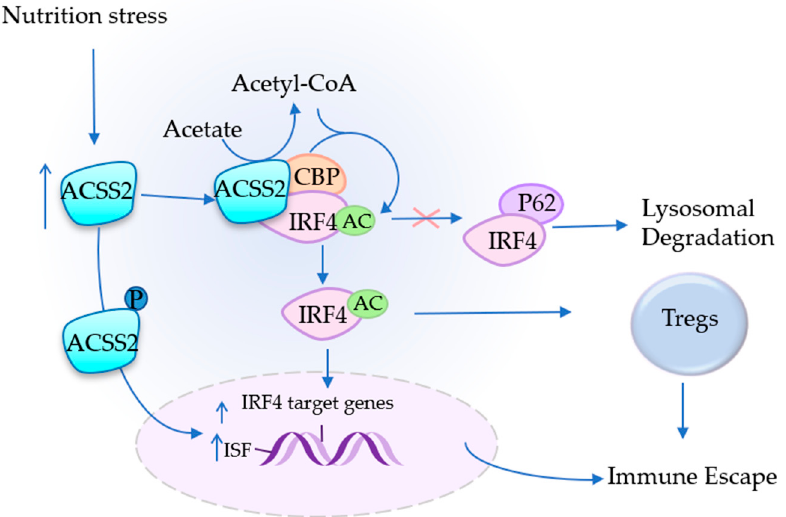
Figure 3. ACSS2 assists in immune escape ACSS2 not only participates in lipid synthesis but also acetylates IRF4 in the cytoplasm to prevent its degradation via ubiquitination (Ubiquitin binding protein P62 is a key molecule that mediates protein degradation.), but also Nucleus-translocatedACSS2 can also promote the gene expression of IRF4 and some immunosuppressive factors (ISF) and promote the immune escape of tumor cells.